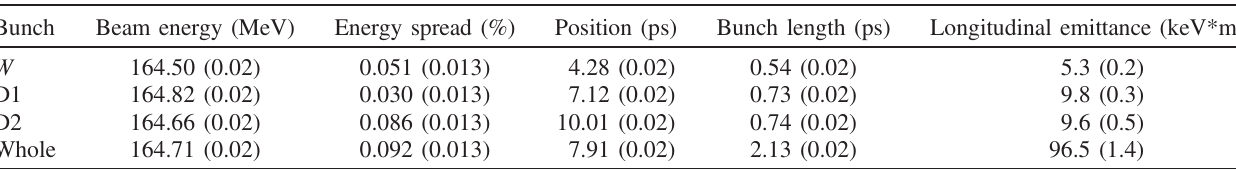
TABLE I. Beam parameter for longitudinal phase space A in Fig. 2. Bunch Beam energy (MeV) Energy spread